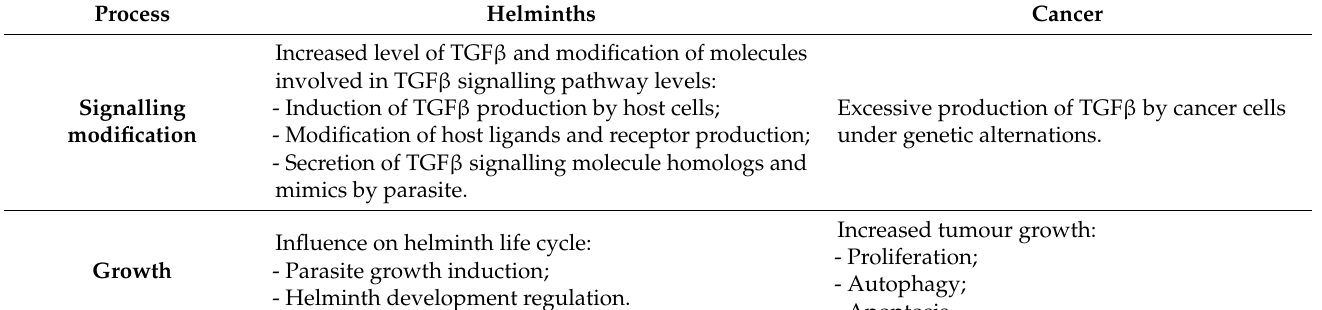
Table 1. Comparison of TGF β participation in various processes during helminthic infection and advanced cancer progression.